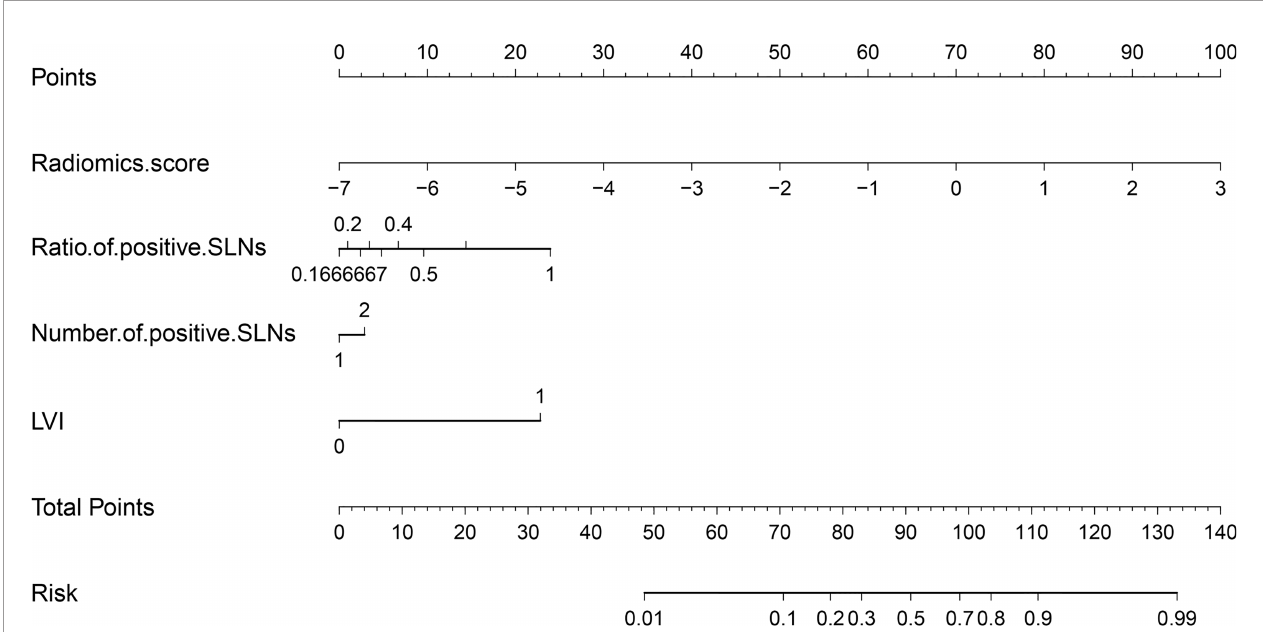
FIGURE 6 | Radiomics nomogram to predict NSLN metastasis. (50% probability is used as the classi fi cation cutoff point, corresponding to 91 points). SLN, sentinel lymph node; LVI, lymphovascular